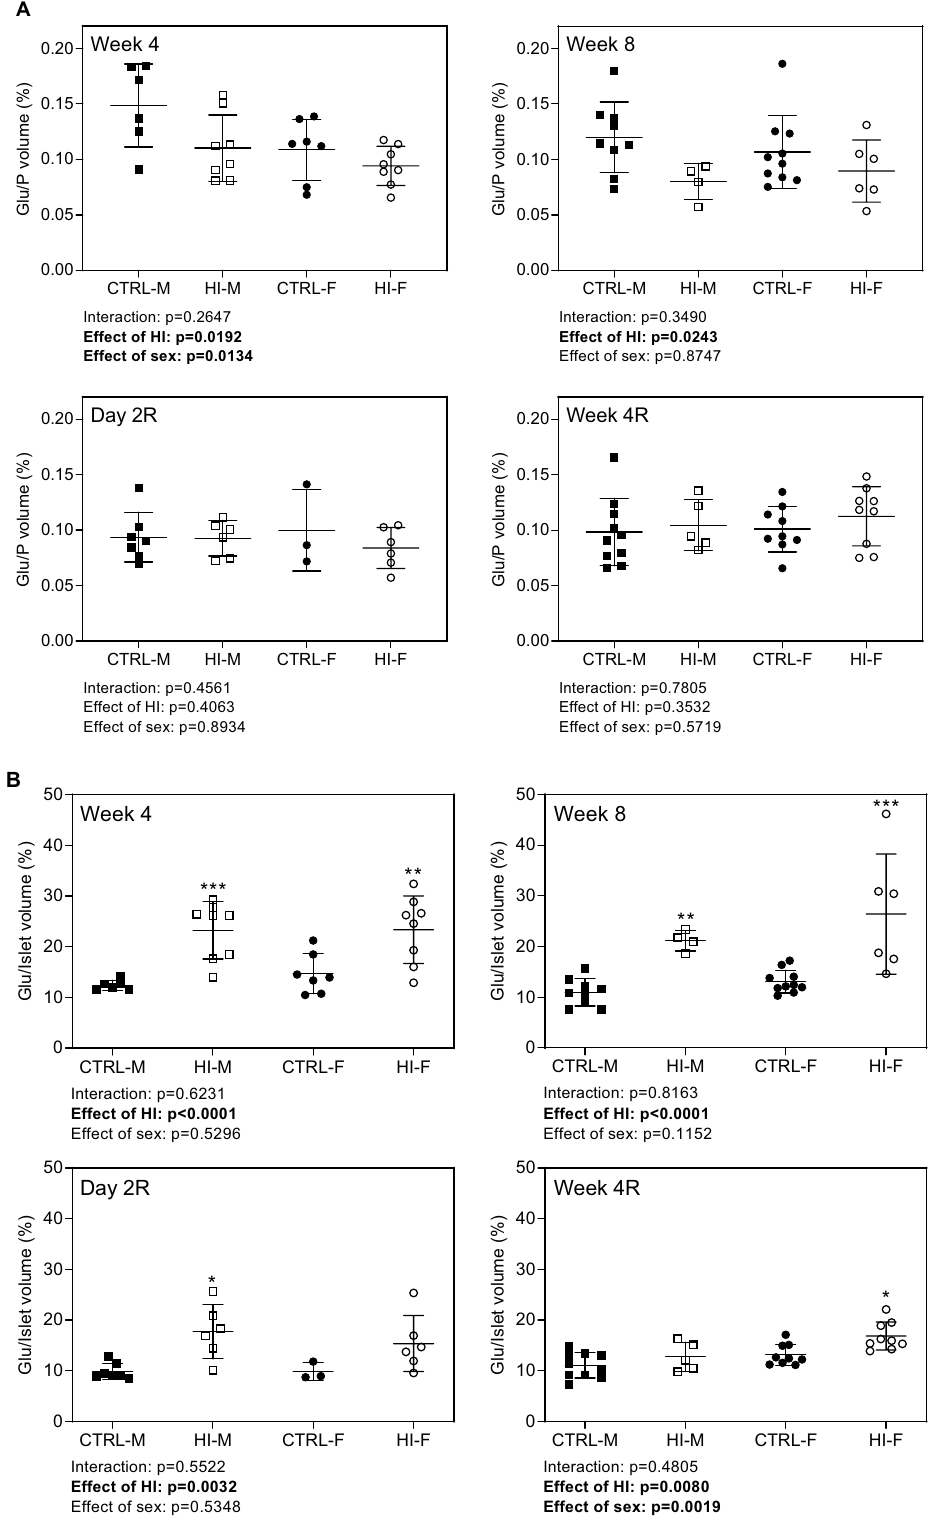
Figure 8. Relative glucagon to pancreas and islet volume, individual (symbols) and means ± SDs. ( A ) Glucagon to pancreas volume, ( B ) Glucagon to islet volume. Week 4 : CTRL-M, n = 6; HI-M, n = 8; CTRL-F, n = 7; HI-F, n = 8. Week 8 : CTRL-M, n = 9; HI-M, n = 4; CTRL-F, n = 10; HI-F, n = 6. Day 2R : CTRL-M, n = 7; HI-M, n = 6; CTRL-F, n = 3; HI-F, n = 6. Week 4R : CTRL-M, n = 10; HI-M, n = 5; CTRL-F, n = 9; HI-F, n = 9. * p < 0.05, ** p < 0.01, *** p < 0.001 versus control group for the same sex. Abbreviations: Glu, glucagon; HI, human insulin; P, pancreas; R, recovery (infusion-free